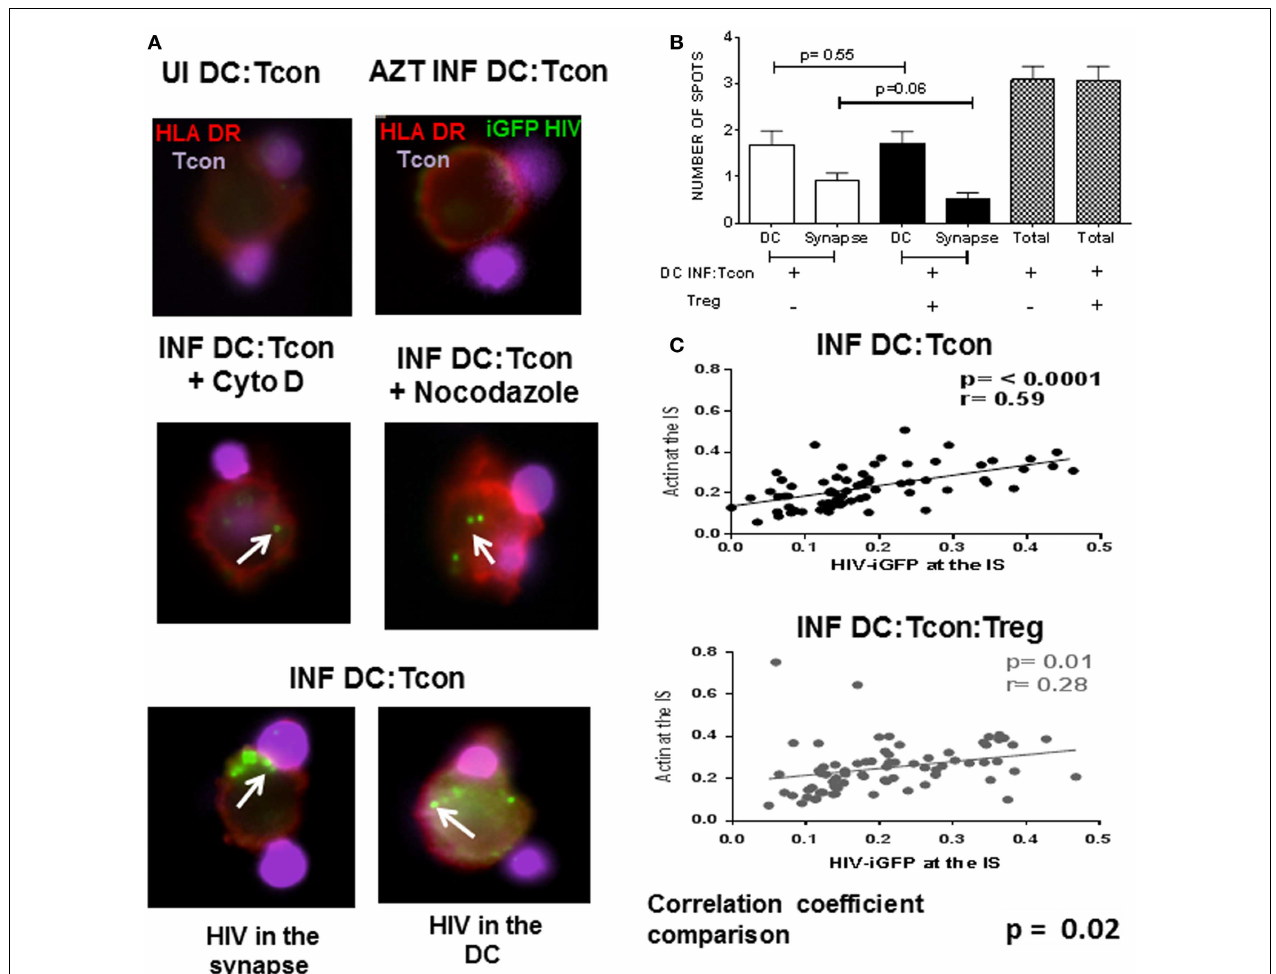
experiments, comparing number of punctate at the IS or DC in the absence and presence ofTreg. p Value corresponds to a paired t -test. (C) HIV migration to the IS was assessed first by quantifying the iGFP-HIV intensity at the synapse divided by the total iGFP-HIV intensity. Second, we quantified the actin intensity at the interface divided by the total actin staining as described in Figure 4 .Third, we plotted these two parameters to track the co-localization of HIV with polymerized actin at the IS. Correlation of actin polymerization and HIV-iGFP localization in DC:Tcon clusters in the absence and presence ofTreg. Correlation coefficients of the two data sets were compared ( p =